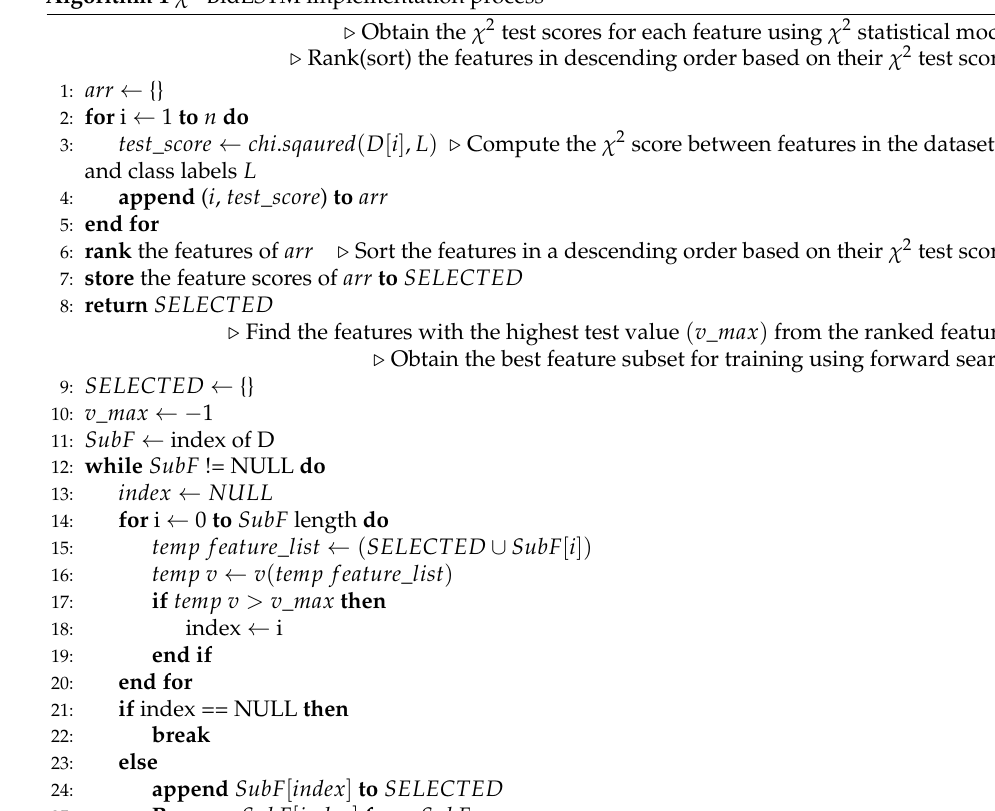
Algorithm 1 χ 2 -BidLSTM implementation